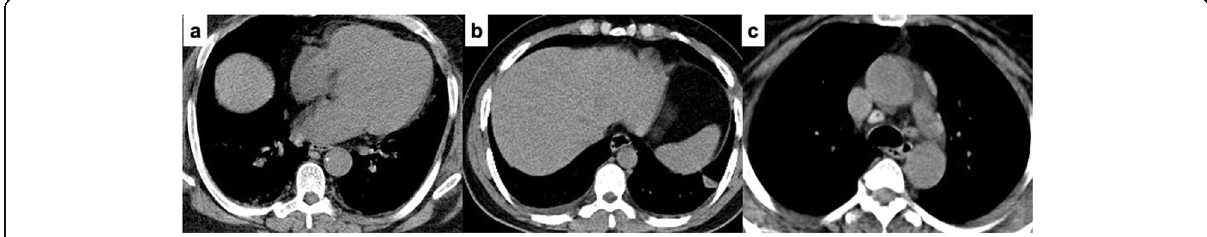
Fig. 6 Axial CT mediastinal window in different cases with COVID-19 pneumonia. a Bilateral pleural thickening. b Right mild size free pleural effusion and left pleural reaction. d Mediastinal reactive lymph nodes noted at the right paratracheal, aortopulmonary, and prevascular regions. Note the high density of lymph